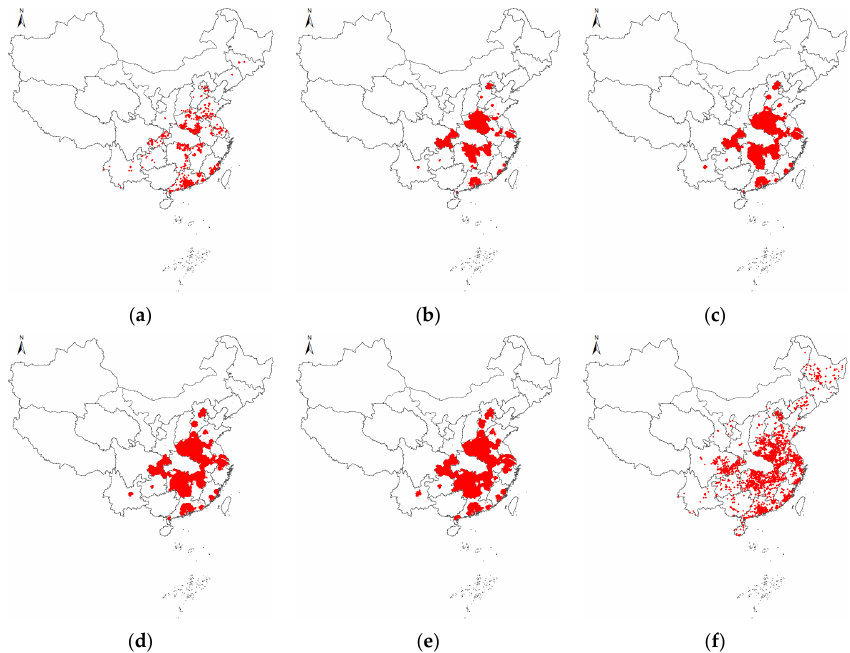
Figure 9. COVID-19 spread under current trends. ( a ) 6 February 2020 (actual data); ( b ) 16 February 2020 (simulated data); ( c ) 26 February 2020 (simulated data); ( d ) 7 March 2020 (simulated data); ( e ) 20 March 2020 (simulated data); ( f ) 20 March 2020 (actual data).